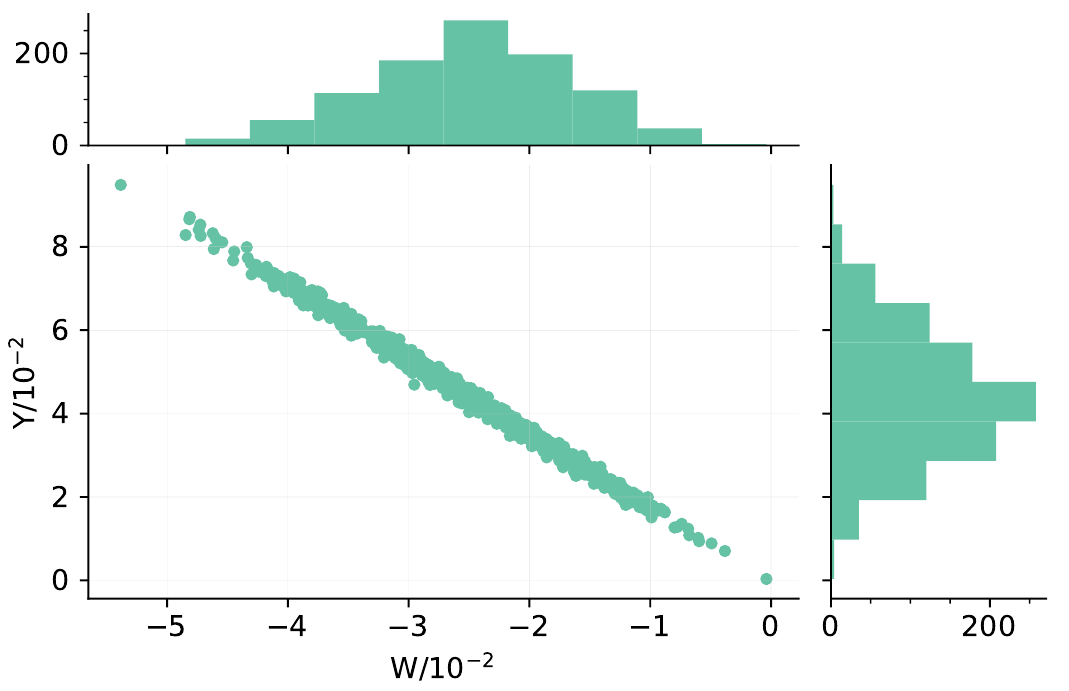
Figure 7 . Scatter plot for the best fit values of ( W, Y ) per replica using ATLAS and CMS high mass Drell-Yan data, which are exclusively NC observables. The upper and rightmost panels are histograms in their respective directions. A clear flat direction has been detected along with a strong